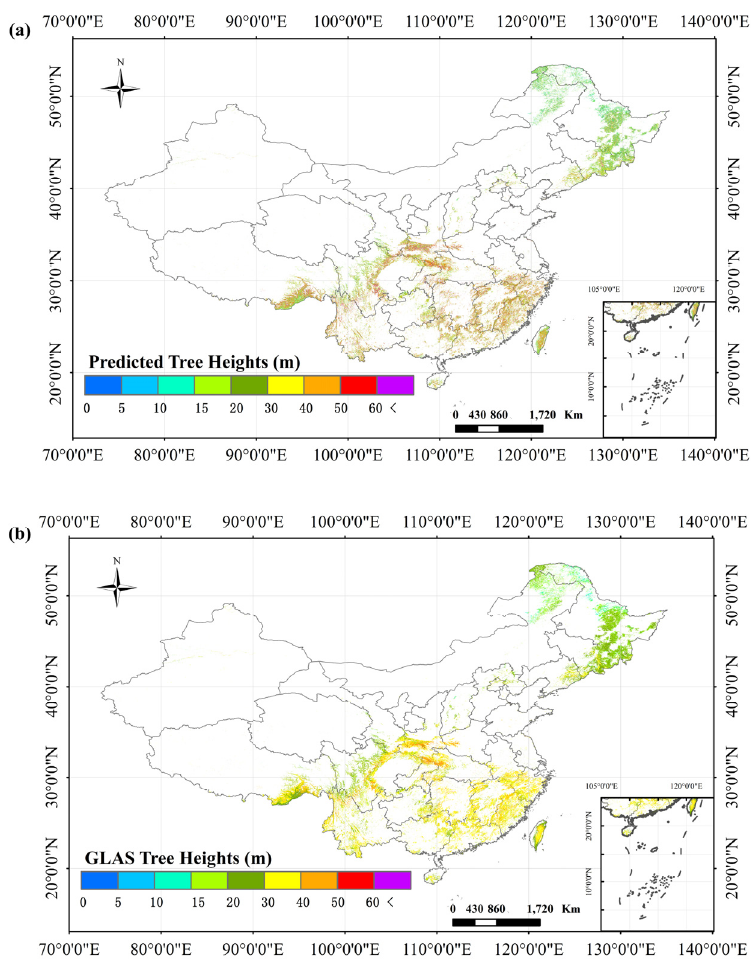
Figure 3. Maps of modeled and averaged GLAS-derived tree heights over continental China at 1-km spatial resolution. ( a ) The modeled height map using the trained ANN model proposed in this paper; ( b ) GLAS tree height map. The GLAS tree height map is made from the interpolation of the averaged GLAS-derived tree